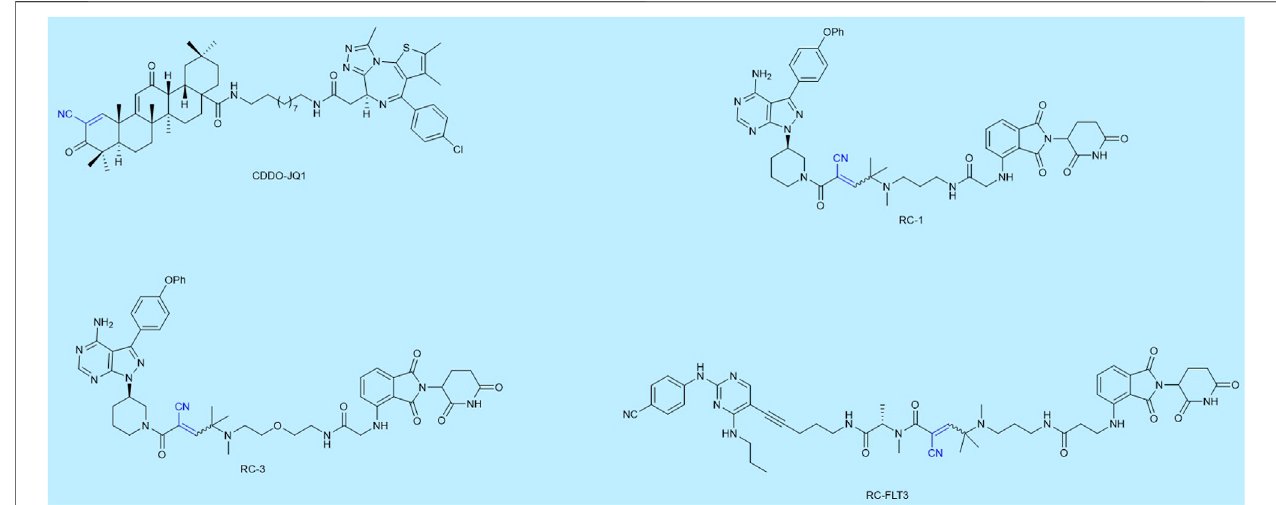
FIGURE 2 | Examples of reversible covalent PROTACs. The names given to the molecules are taken from the publications in which they are described.